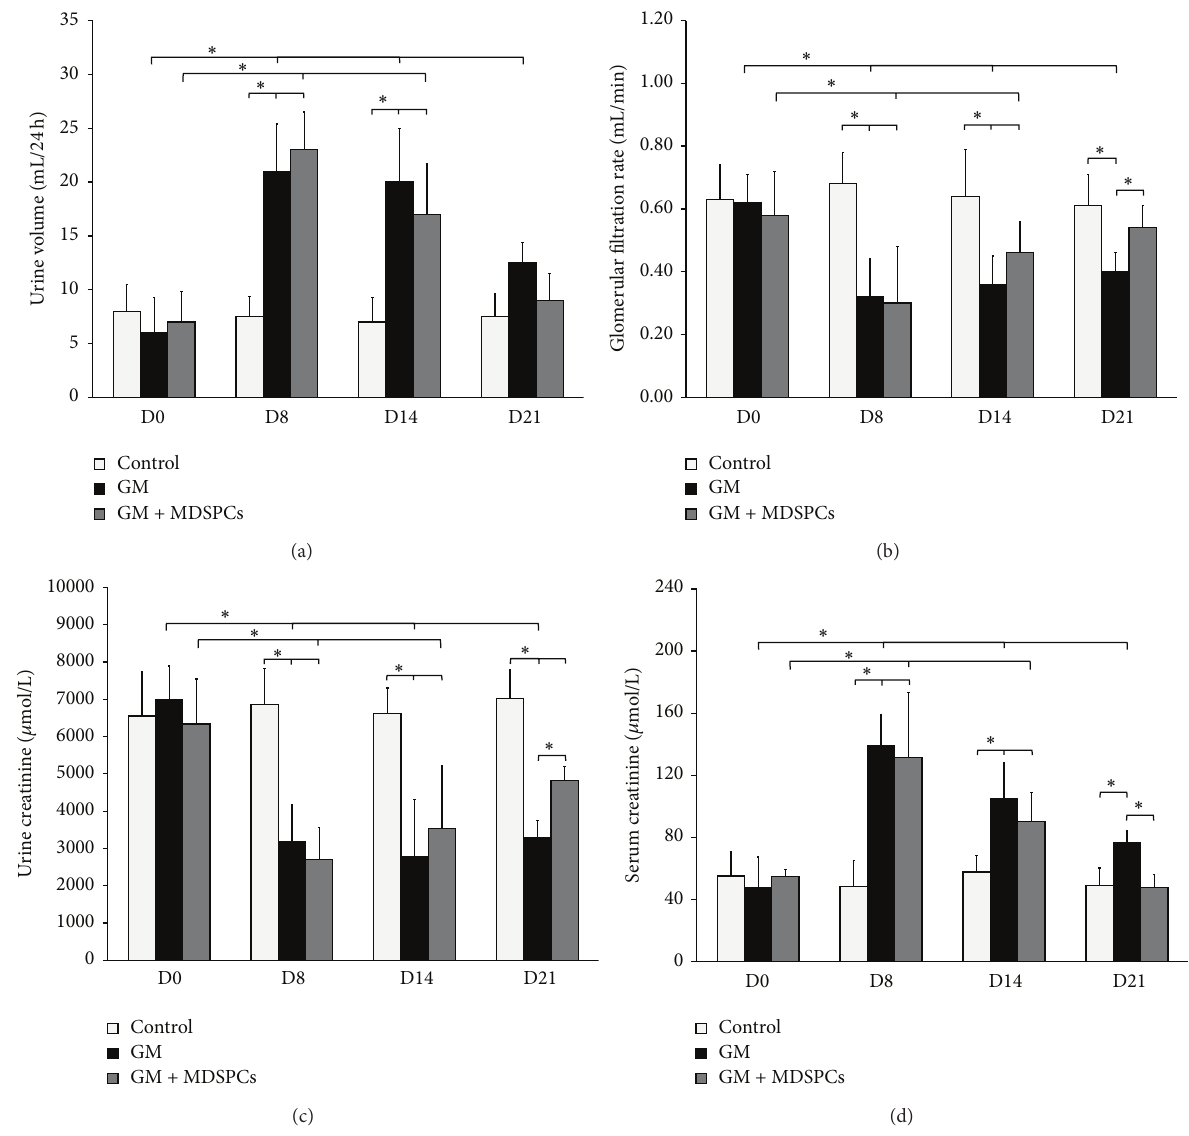
Figure 5: MDSPCs impact on functional recovery of damaged kidney. Gentamicin-induced acute kidney injury was validated by the presence of physiological and functional changes in all rats from GM and GM + MDSPCs groups ((a), (b), (c), and (d), D8). There was no significant difference in urine volume between GM and GM + MDSPCs groups at any time point ((a); 𝑝 > 0.05 ). The MDSPCs accelerated the recovery after AKI, as reflected by significantly higher GFR ((b); 𝑝 = 0.034 ), increased urinary creatinine levels ((c); 𝑝 = 0.015 ), and lower serum creatinine ((d); 𝑝 = 0.030 ) as compared to the GM group rats that were not treated with MDSPCs. ∗ 𝑝 < 0.05 , significant